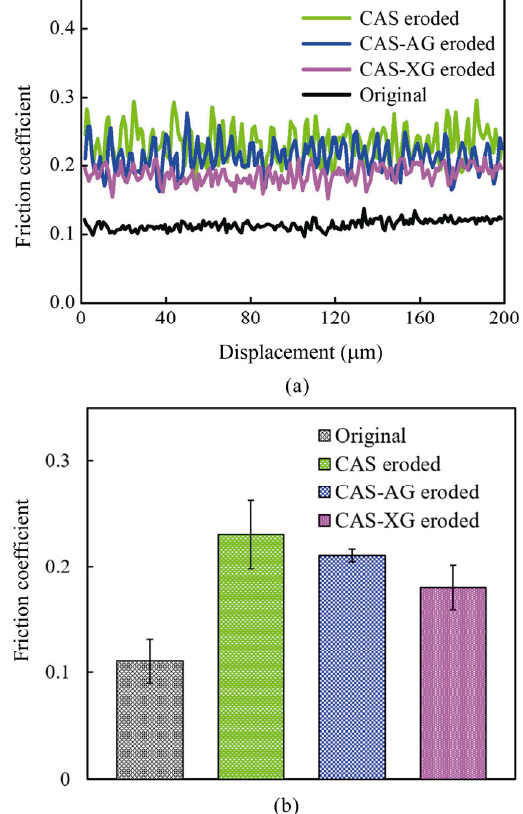
Fig. 5 Friction curves and average friction coefficients of the enamel surfaces subjected to different erosion treatments at applied load of 10 mN: (a) variations of friction coefficients versus displacement; (b) average friction coefficient.